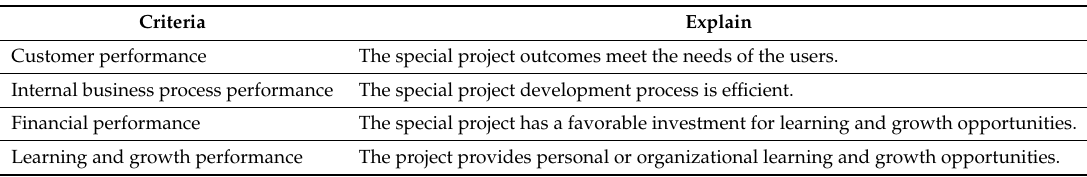
Table 3. Explanation of organizational performance